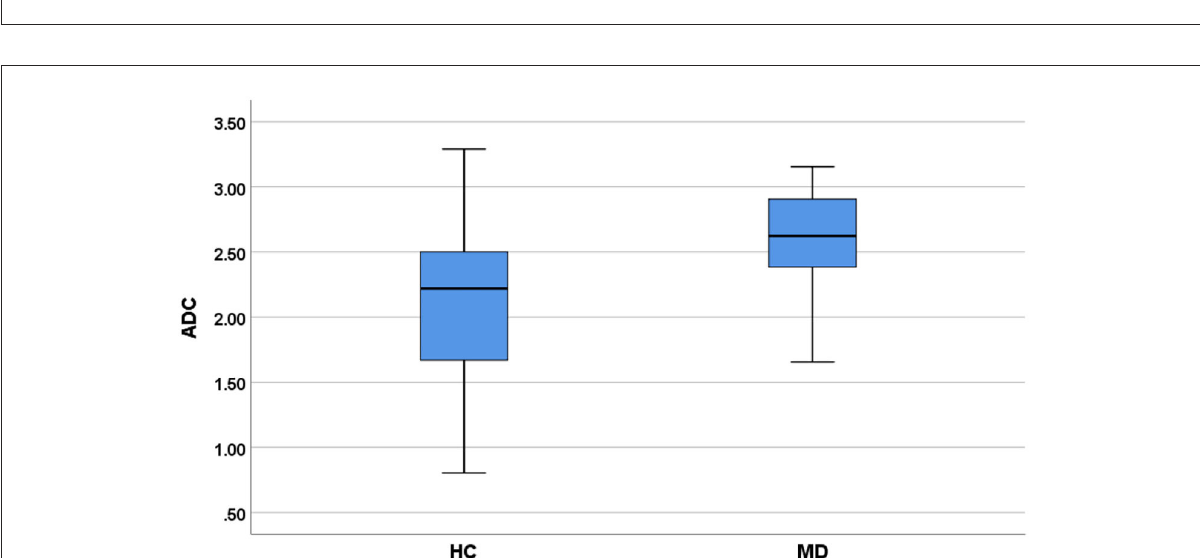
FIGURE4 Comparison of ADC values (VCN) between MD patients and healthy controls (HC).